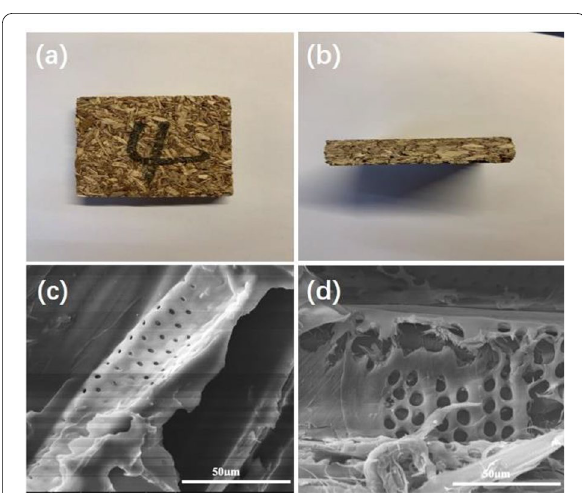
Fig. 9 Photographs and SEM micrographs of cross-sectional surface of particleboard with density 0.5 g/cm 3 : a and b Surface and cross-section photographs of the particleboards; c the control group; d the treatment